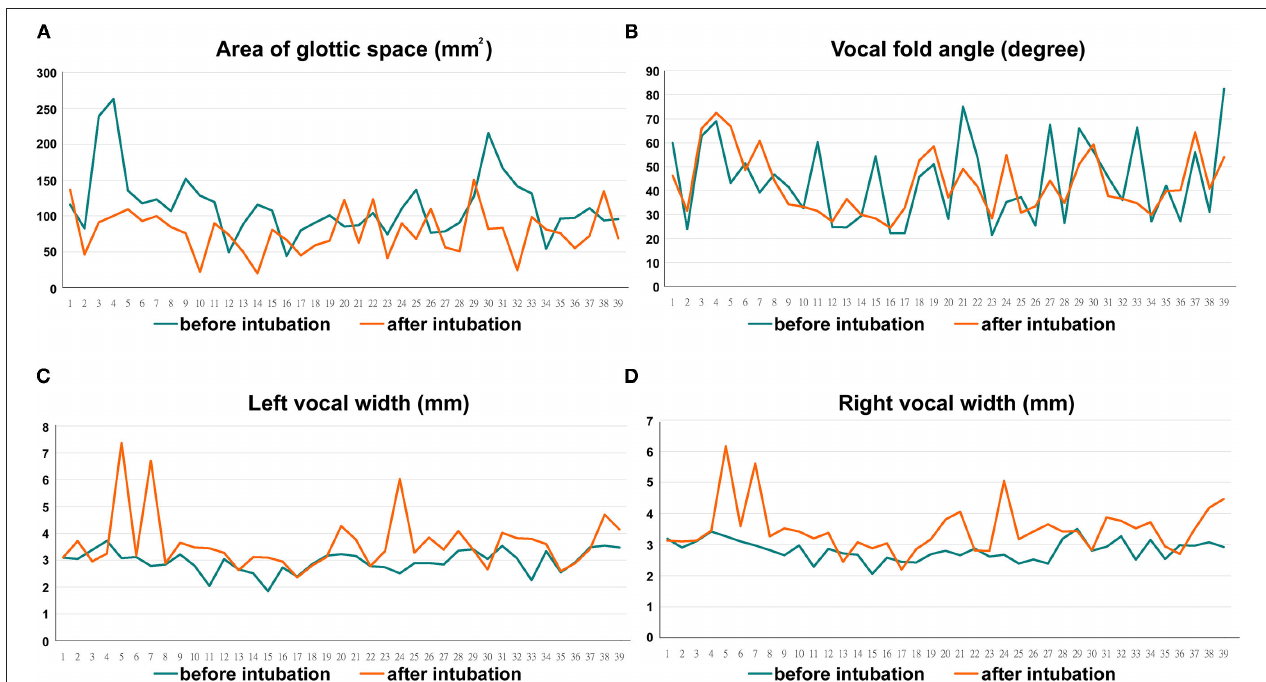
FIGURE 4 | The changes in maximum value of the glottic area (31.2% decrease) (A) , vocal fold angle (2.58% decrease) (B) , and vocal fold width (Left vs. right: 22.01 vs. 23.46% increase, respectively) (C&D) .